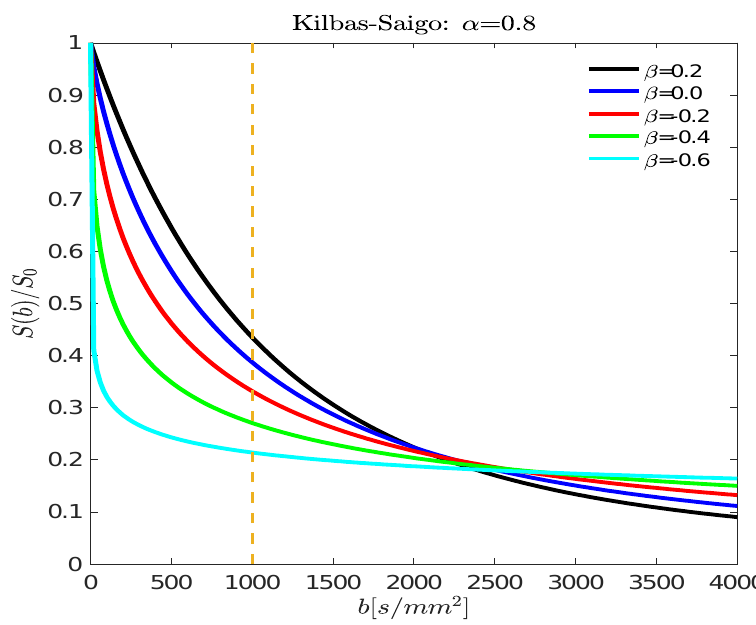
Figure 6. The normalized stretched Kilbas-Saigo signal decay of S(b) / S 0 is plotted versus b -values between 0 and 4000 s / mm 2 , and D 0 = 1 × 10 − 3 mm 2 / s with α = 0.8, and β = 0.2, 0, − 0.2, − 0.4, and − 0.6. In this figure, we observe the effects of both α and β on the decay.